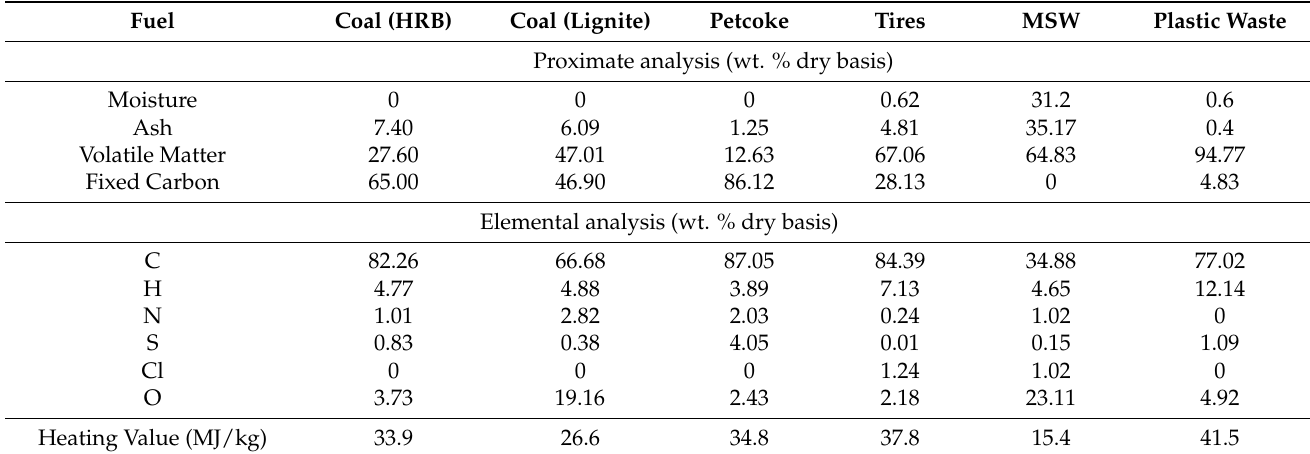
Table 1. Proximate and elemental analyses of solid fuels